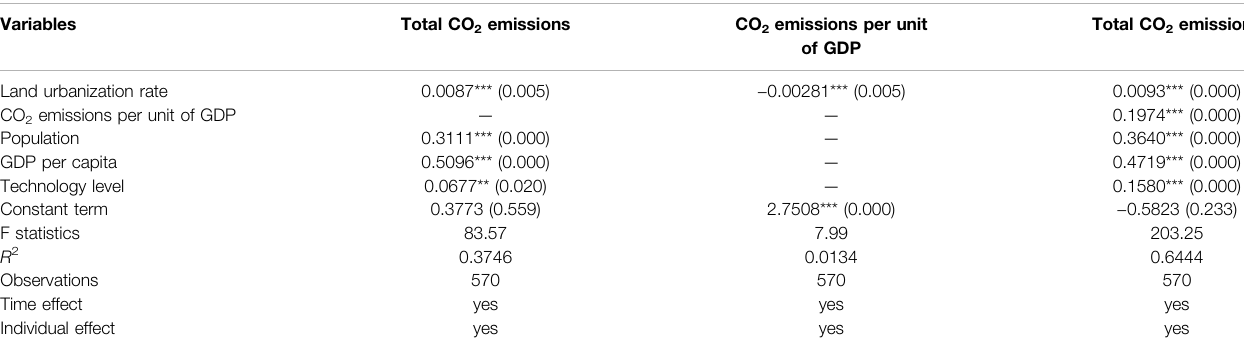
TABLE 6 | The mediating effect of CO 2 emissions per unit of